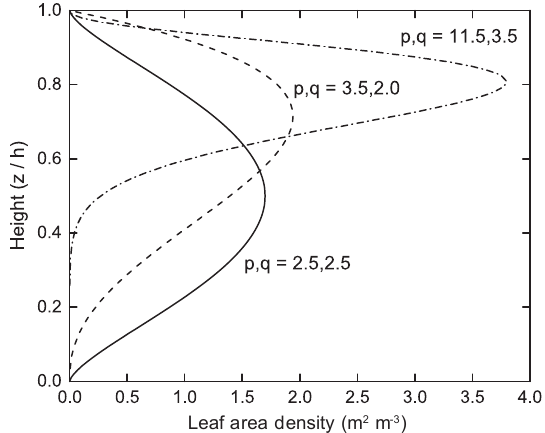
Figure 3. Profiles of leaf area density. Shown are three different canopy profiles for: (i) grass and crop with p = q = 2 . 5; (ii) de- ciduous and spruce trees with p = 3 . 5 and q = 2 . 0; and (iii) pine trees with p = 11 . 5 and q = 3 . 5. These profiles are show here with L T /h = 0.5 m 2 m − 3